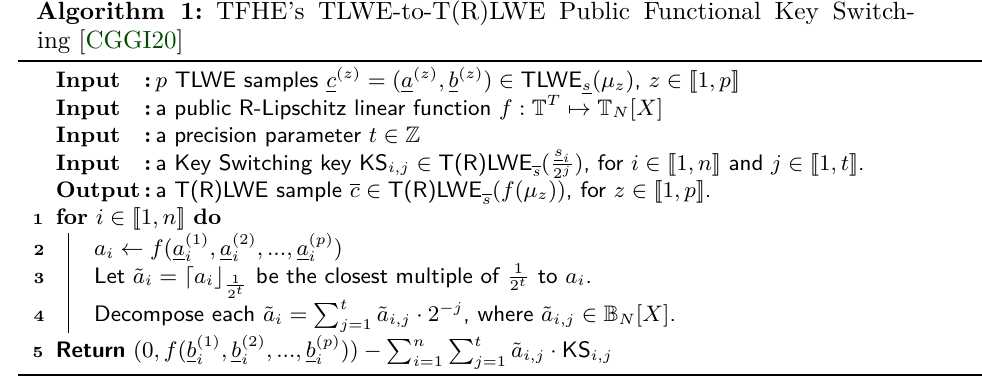
Algorithm 1: TFHE’s TLWE-to-T(R)LWE Public Functional Key Switch- ing